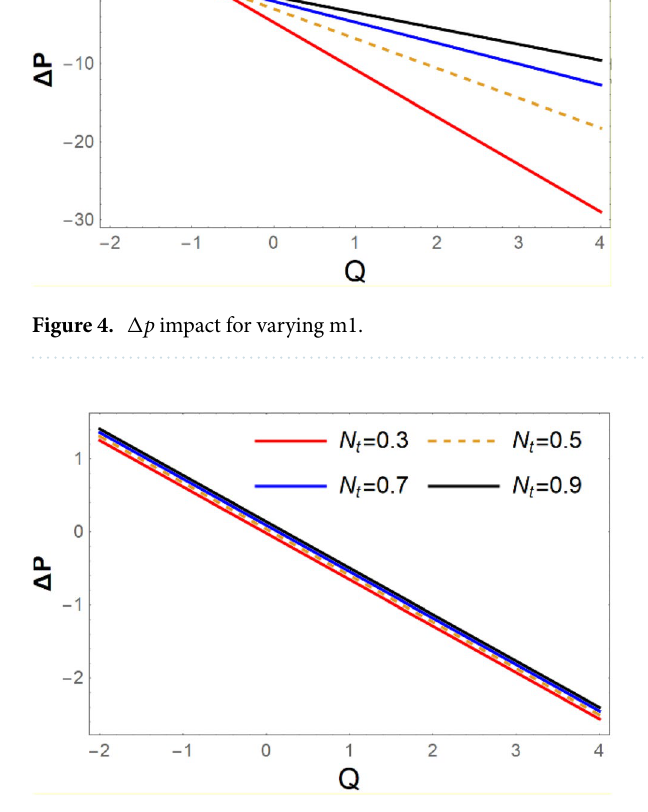
Figure 5. (cid:31) p impact for varying profile for N t .